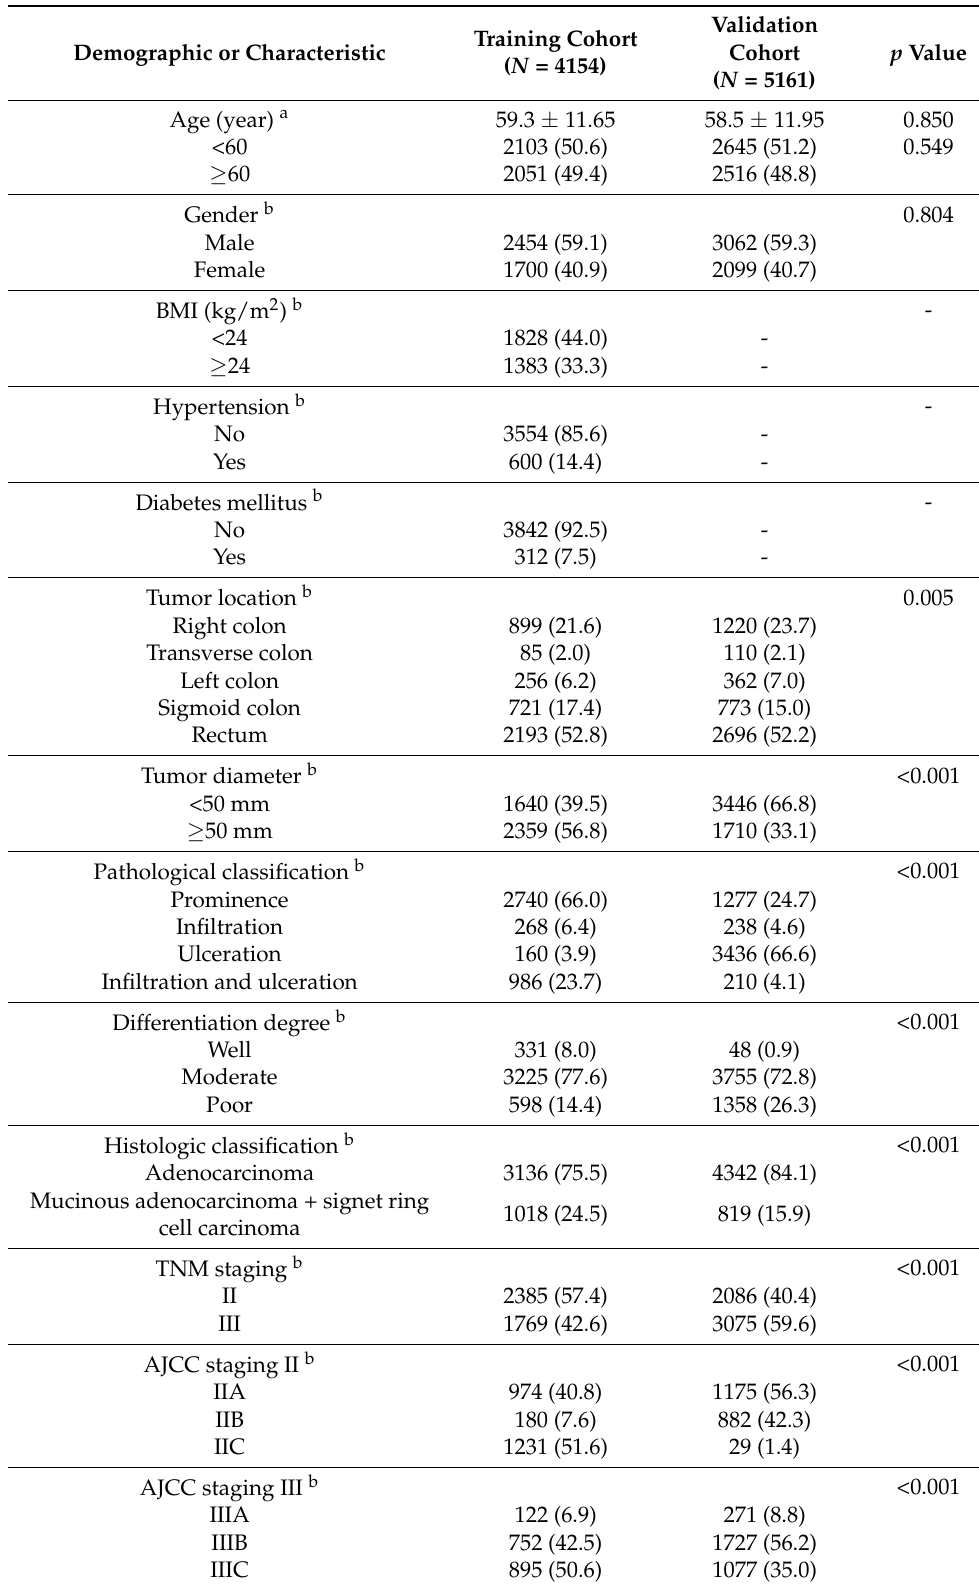
Table 1. Patients’ baseline characteristics in the training and validation